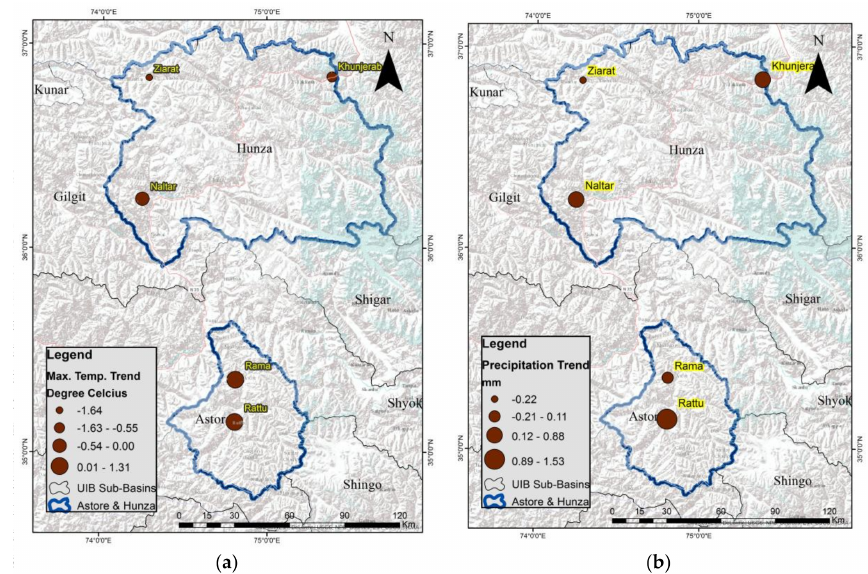
Figure 4. Shows the Mann-Kendall trend of meteorological variables, maximum temperature ◦ C · year − 1 and precipitation mm · year − 1 in the Hunza and Astore basins. ( a ) Maximum temperature; ( b ) Precipitation.